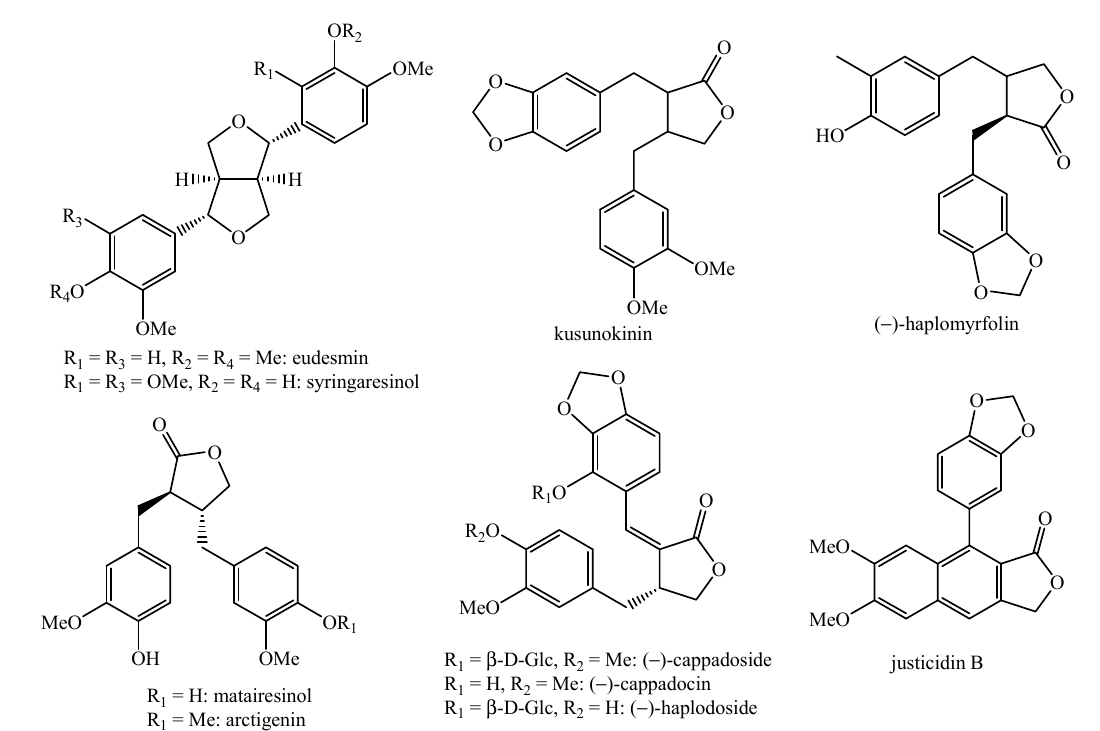
Figure 10. Structure of the lignans identified in Haplophyllum species—part 1.